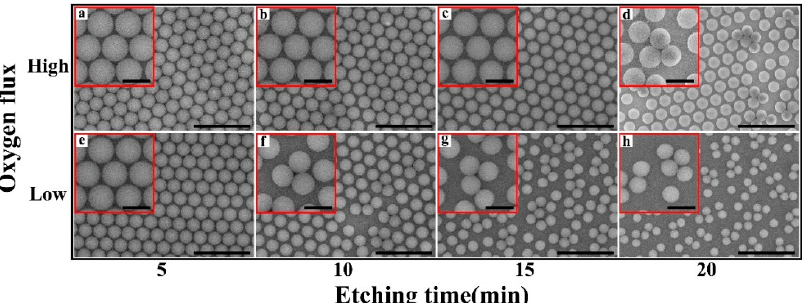
Figure 4. SEM images of the PS nano-spheres etched by the high-flux and low-flux oxygen plasma etching. PS nano-spheres etched by the high-flux oxygen plasma etching with an etching time of ( a ) 5 min, ( b ) 10 min, ( c ) 15 min, and ( d ) 20 min, respectively. PS nano-spheres etched by the low-flux oxygen plasma etching with an etching time of ( e ) 5 min, ( f ) 10 min, ( g ) 15 min, and ( h ) 20 min, respectively. The scale bar is 2 μ m. The magnified image was inserted in each image. The scale bar in the magnified images is 500 nm. It should be noticed that coalesced nano-spheres firstly appeared in ( d ) and ( f